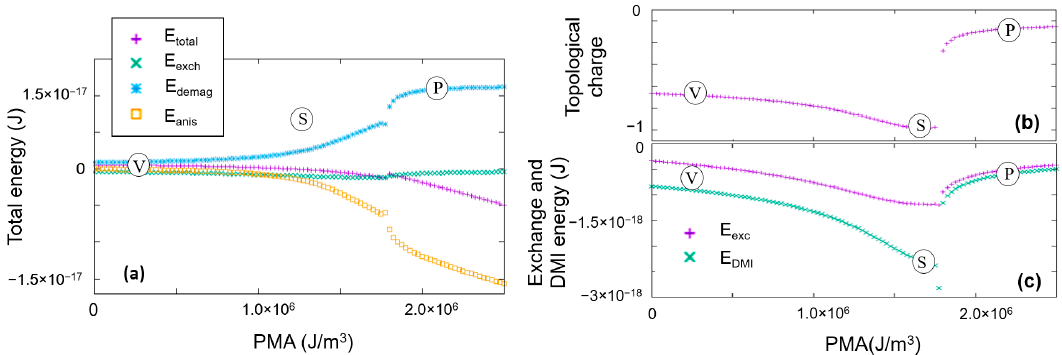
Figure 16. Total energy density line profile evolution with DMI and PMA for: ( a ) DMI increase at fixed PMA (along the line (1), Figure 15(a)) and ( b ) PMI increase at fixed DMI (line (2), Figure 15a). Evolution of the energy barrier ∆𝐸 (cid:3031)(cid:3032)(cid:3041)(cid:3046) with the increase in the DMI ( c ) and PMA ( d ) .